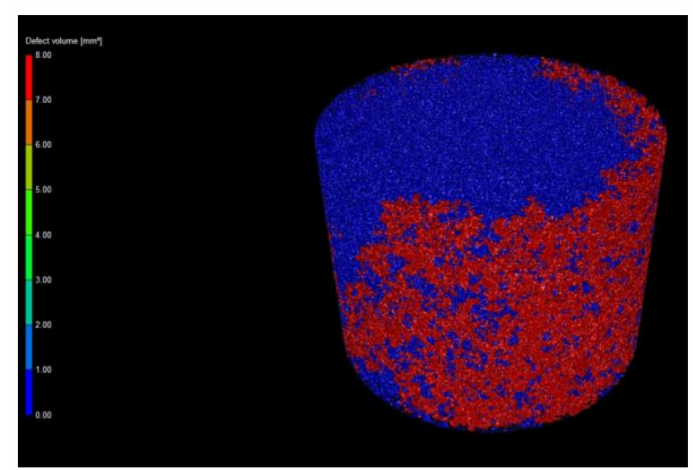
Figure 5. The Cu–graphite sample with 90 vol. % graphite investigated using X-ray tomography: a surface cluster of copper is in red; volumetric copper cluster is in blue (sample diameter is 8 mm).